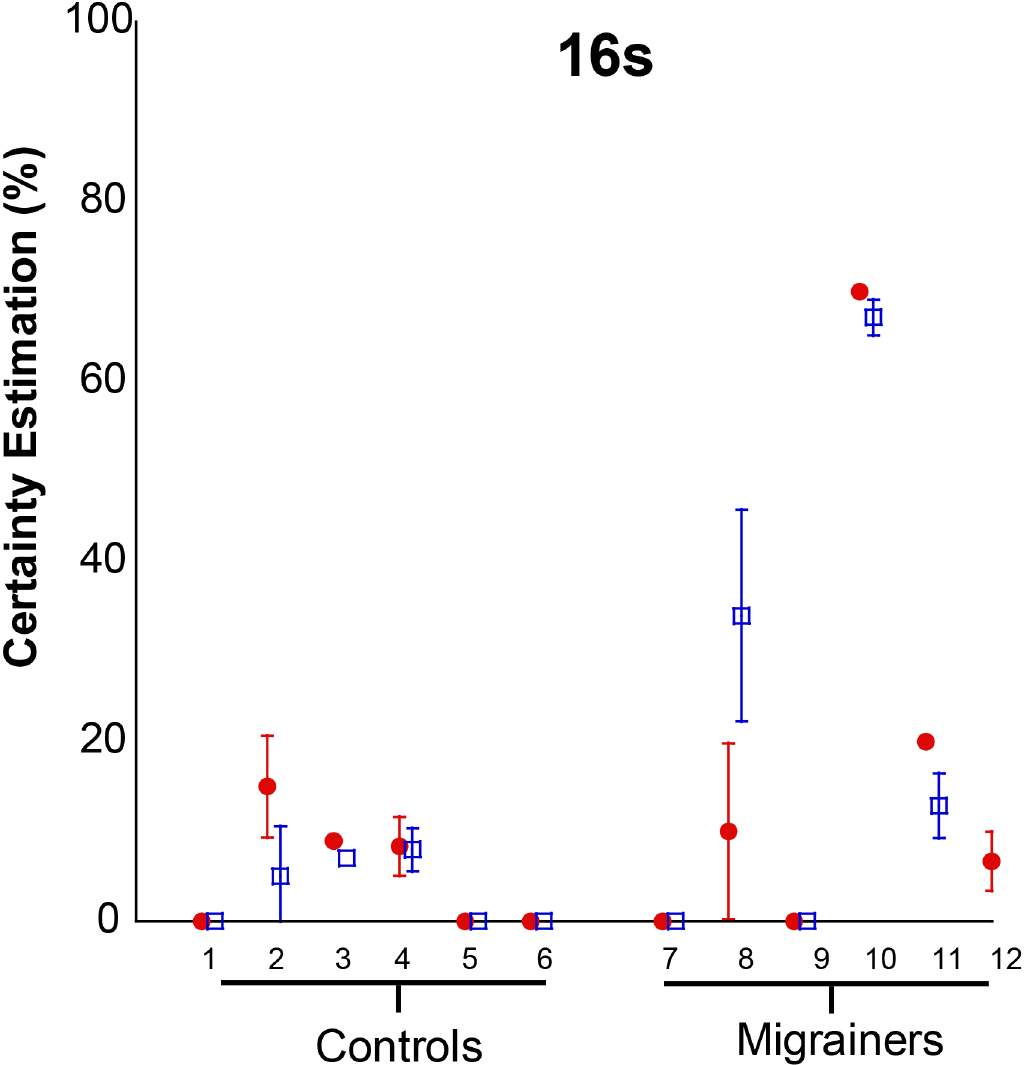
Fig 16. 16s Certainty Estimate — Individual Data for Experiment 3. 8 stimuli were delivered in each trial with either the looming (red circles) or receding (blue squares) VFM. Mean certainty estimates are shown with error bars representing 95%